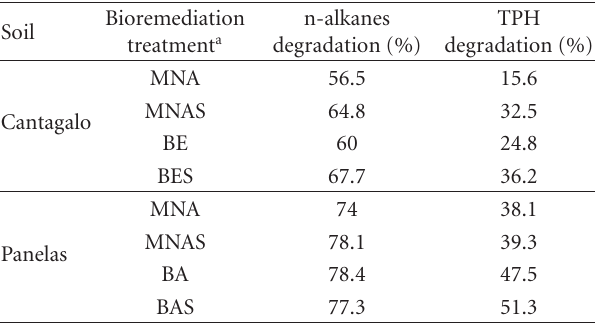
Table 3: Degradation rates of n-alkanes and TPH for each bioremediation